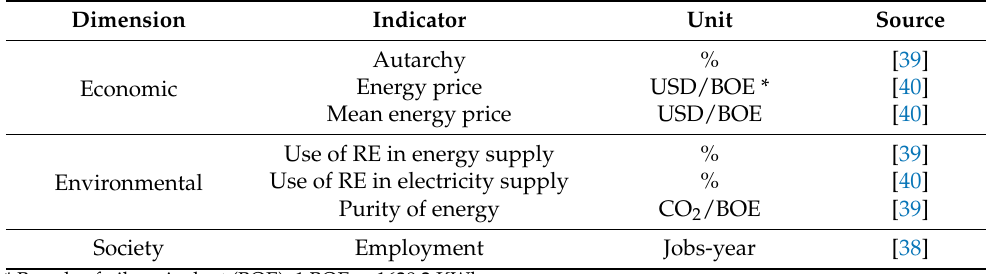
Table 8. Energy sustainability